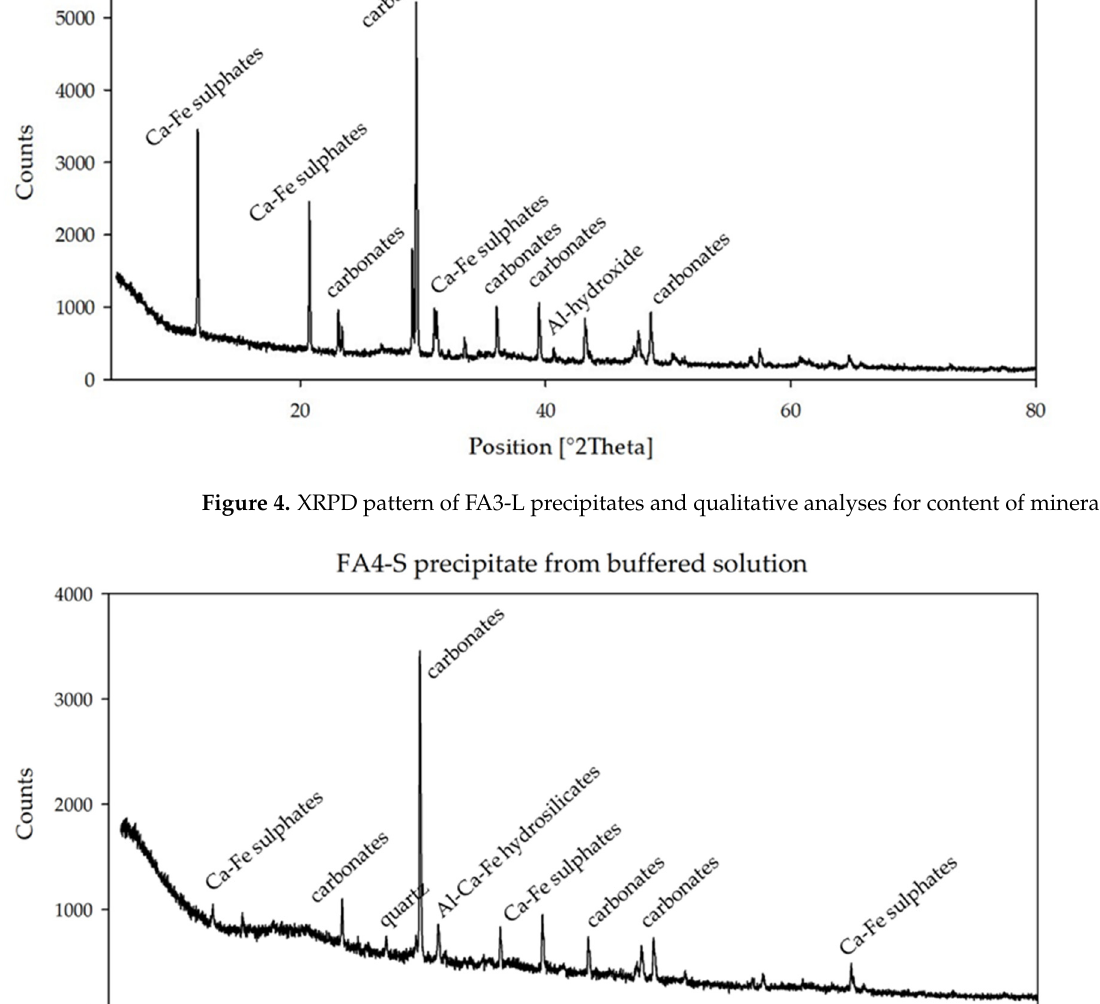
Figure 5. XRPD pattern of FA4-S precipitates and qualitative analyses for content of mineralogical phases. Precipitates of sample FA4-S show the presence of Ca-Fe-sulfates, Al-Ca-Fe-hydrosilicates, carbonates and quartz (Figure 5), while precipitates at higher pH (sample FA4-L) (Figure